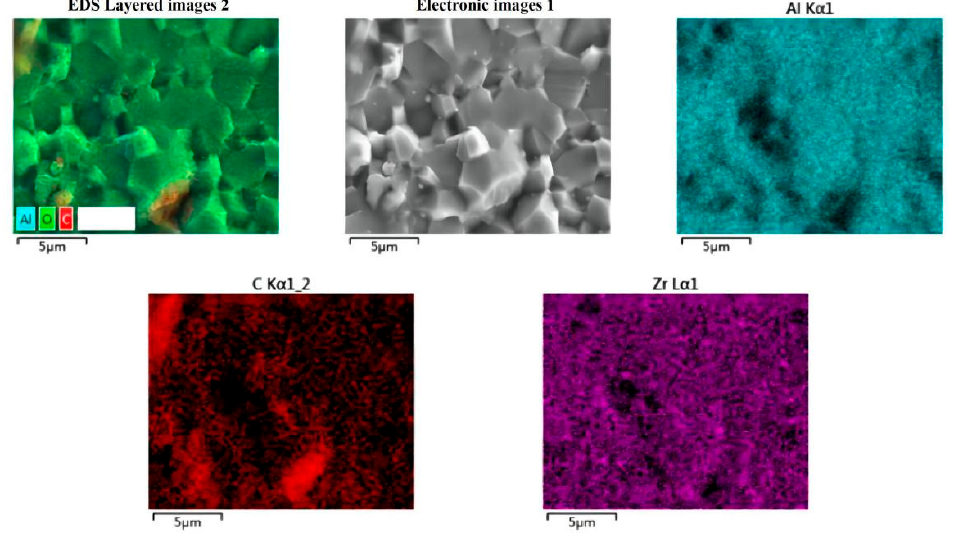
Figure 2. EDS images of Al 2 O 3 -G-M.